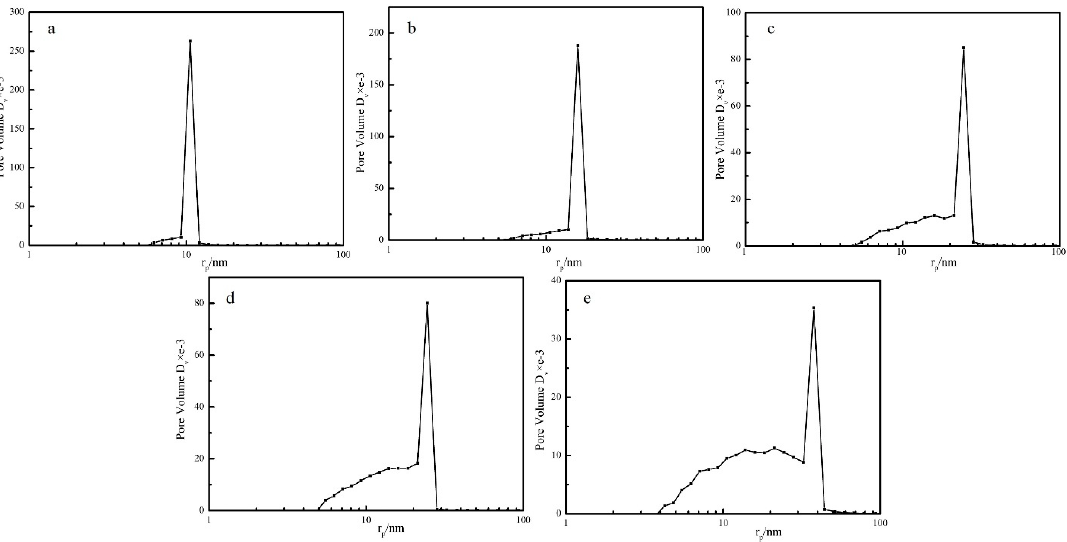
Figure 10. Pore size distribution of PEEK hollow fiber membrane prepared at di ff erent annealing temperatures ( a : 240 ◦ C; b : 250 ◦ C; c : 260 ◦ C; d : 270 ◦ C; e : 280 ◦ C). Table 1. Dimension, porosity and water flux of hollow fiber membranes at di ff erent annealing temperatures.